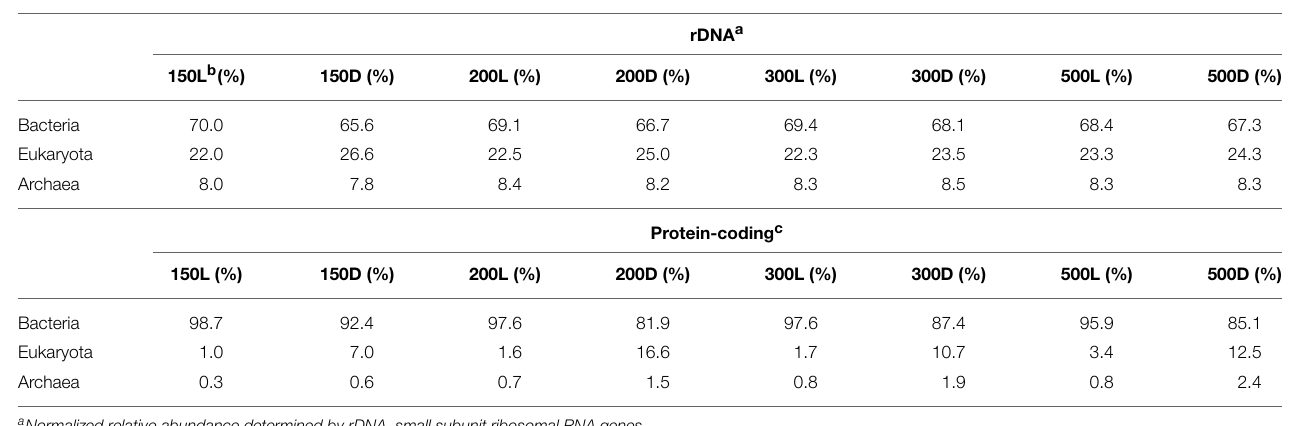
TABLE 1 | The relative abundance of Bacteria, Eukaryota, and Archaea in live (L) and dead (D) sediment traps.